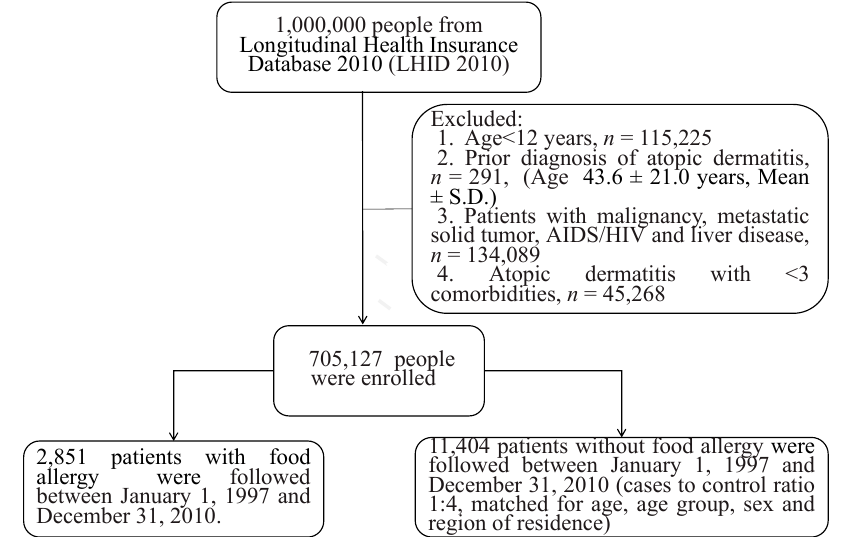
Figure 1. Flow chart of the diagnostic process for food allergy and atopic dermatitis using the Longitudinal Health Insurance Database (LHID) 2010